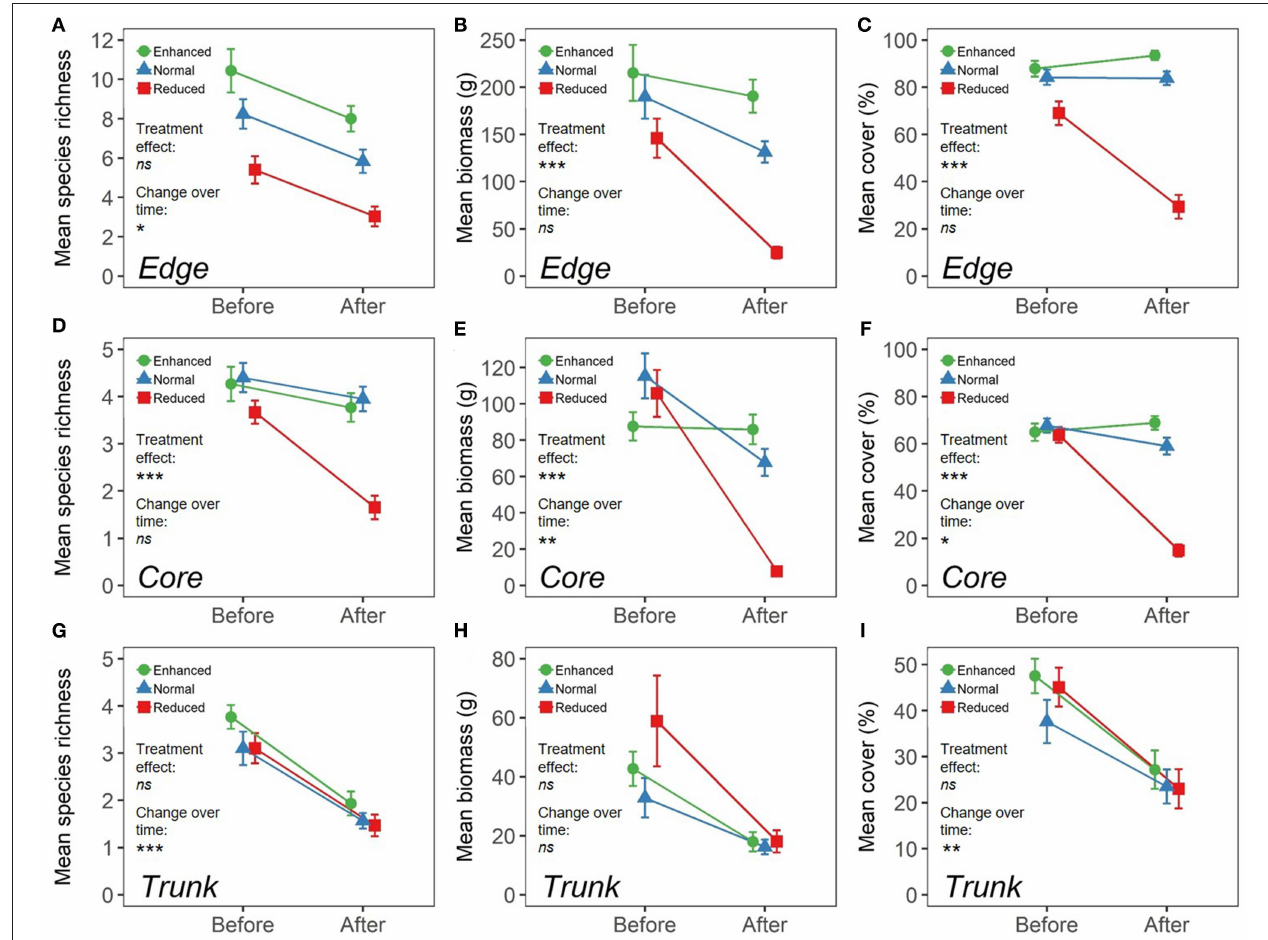
FIGURE 3 | Measures of vegetation within three different microhabitats (understory at plot edge, “Edge”; understory at plot core, “Core”; oil palm trunk, “Trunk”) across different BEFTA Understory Vegetation Project plots (“Enhanced”-shown by green circles; “Normal”-shown by blue triangles; “Reduced”-shown by red squares) both before and after experimental treatments were initiated. During the “Before” time-period all plots were managed using Normal levels of understory vegetation management, but during the “After” time-period, management was adjusted according to treatment type. Results for Edge microhabitats are shown in panels (A–C) ; Core microhabitats are shown in panels (D–F) ; and Trunk are shown in panels (G–I) . Panels (A,D,G) show mean species richness ( ± SE) per 1m 2 quadrat. Panels (B,E,H) show mean biomass (g) ( ± SE) per 1m 2 quadrat. Panels (C,F,I) show mean percentage cover ( ± SE) per 1m 2 quadrat. Note that the scales are different across panels. Effects of changing understory vegetation management as part of the BEFTA Understory Vegetation Project are indicated under “Treatment effect,” with asterisks showing that there was a significant change in the response variable as a result of the experimental treatments beginning (*** p < 0.001; ** p < 0.01; * p < 0.05; ns, not significant) (refer to Supplementary Table 3 for full results). Changes in the response variable over time are indicated under “Change over time,” with asterisks showing that there was a significant change in the response variable in Normal plots between Before and After time-periods (*** p < 0.001; ** p < 0.01; * p < 0.05; ns, not significant) (refer to Supplementary Table 4 for full results).